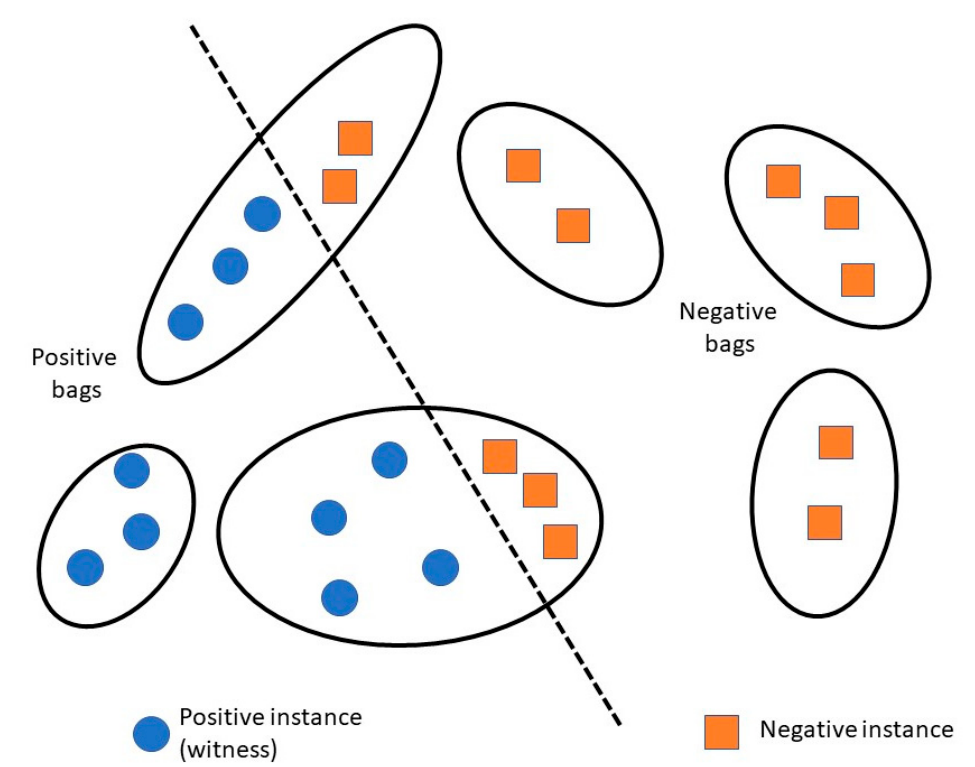
Figure 2. Overview of multiple instance learning (MIL) framework. Each gene (black ellipse) is considered a bag, where each mRNA isoform (circle or square within the ellipse) is considered an instance of the bag. A gene associated with a function is a positive bag, and all instances (mRNA isoforms) associated with that function are called “witnesses”.